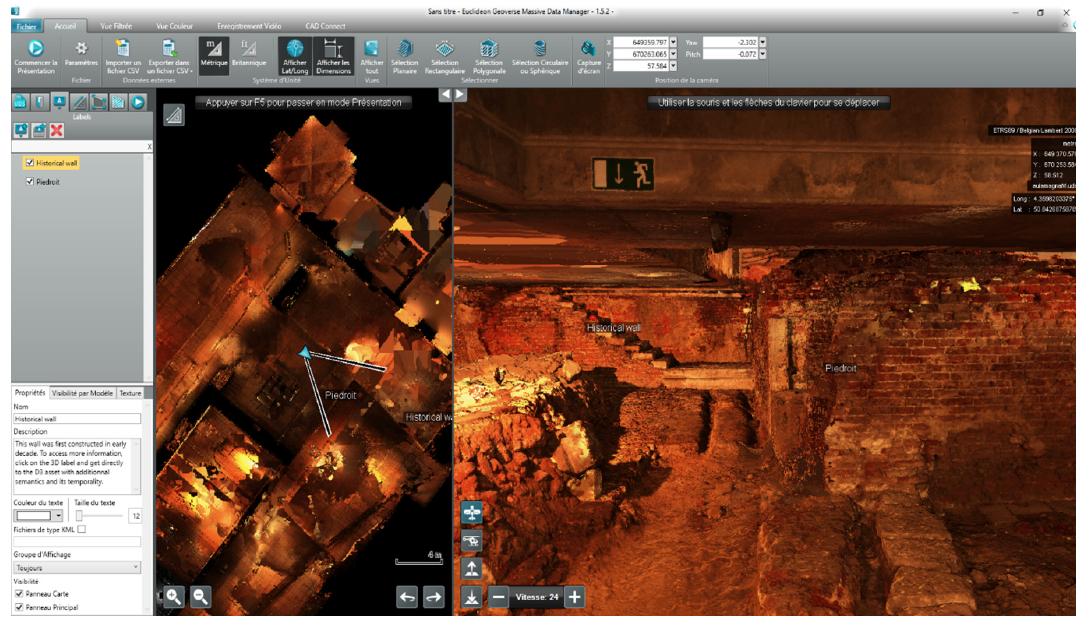
Figure 22. The Geoverse interface.